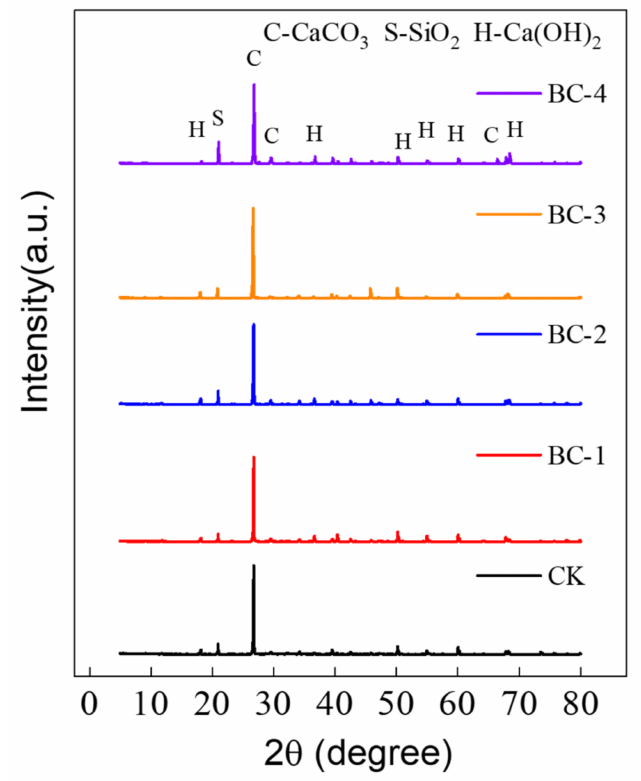
Figure 9. XRD image of biochar concrete with different fineness levels at 3%